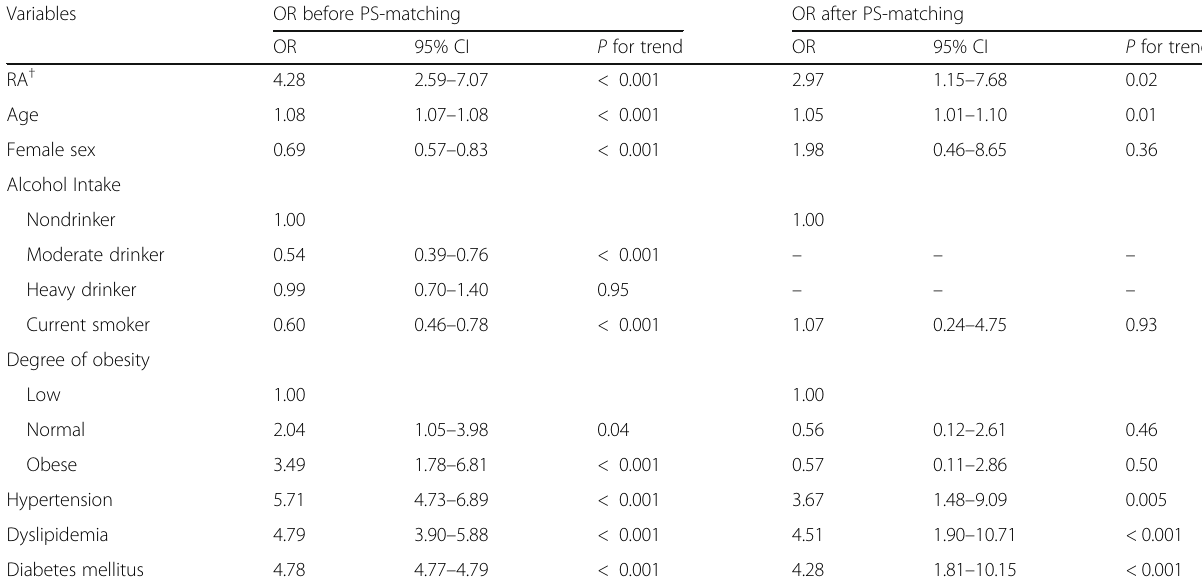
Table 4 Influence of rheumatoid arthritis on coronary artery disease